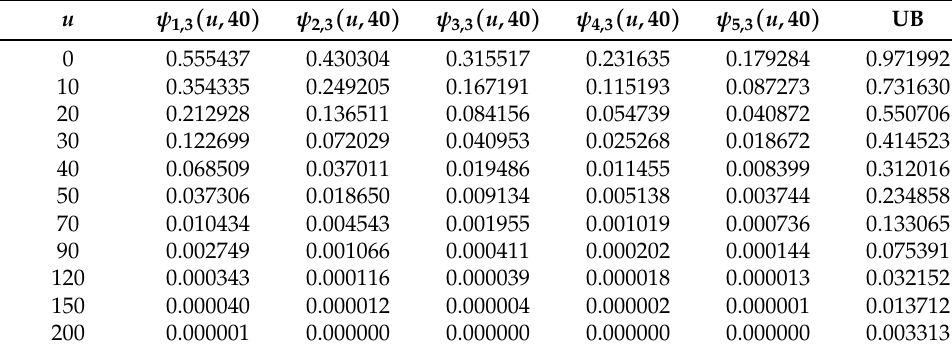
Table 9. ψ i ,3 ( u ,40 ) values with upper bounds (UB).